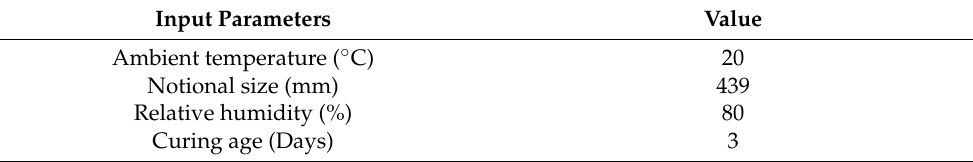
Table 4. Input parameter for Euro-code 2 EN 1992-1-1creep and shrinkage model. Input